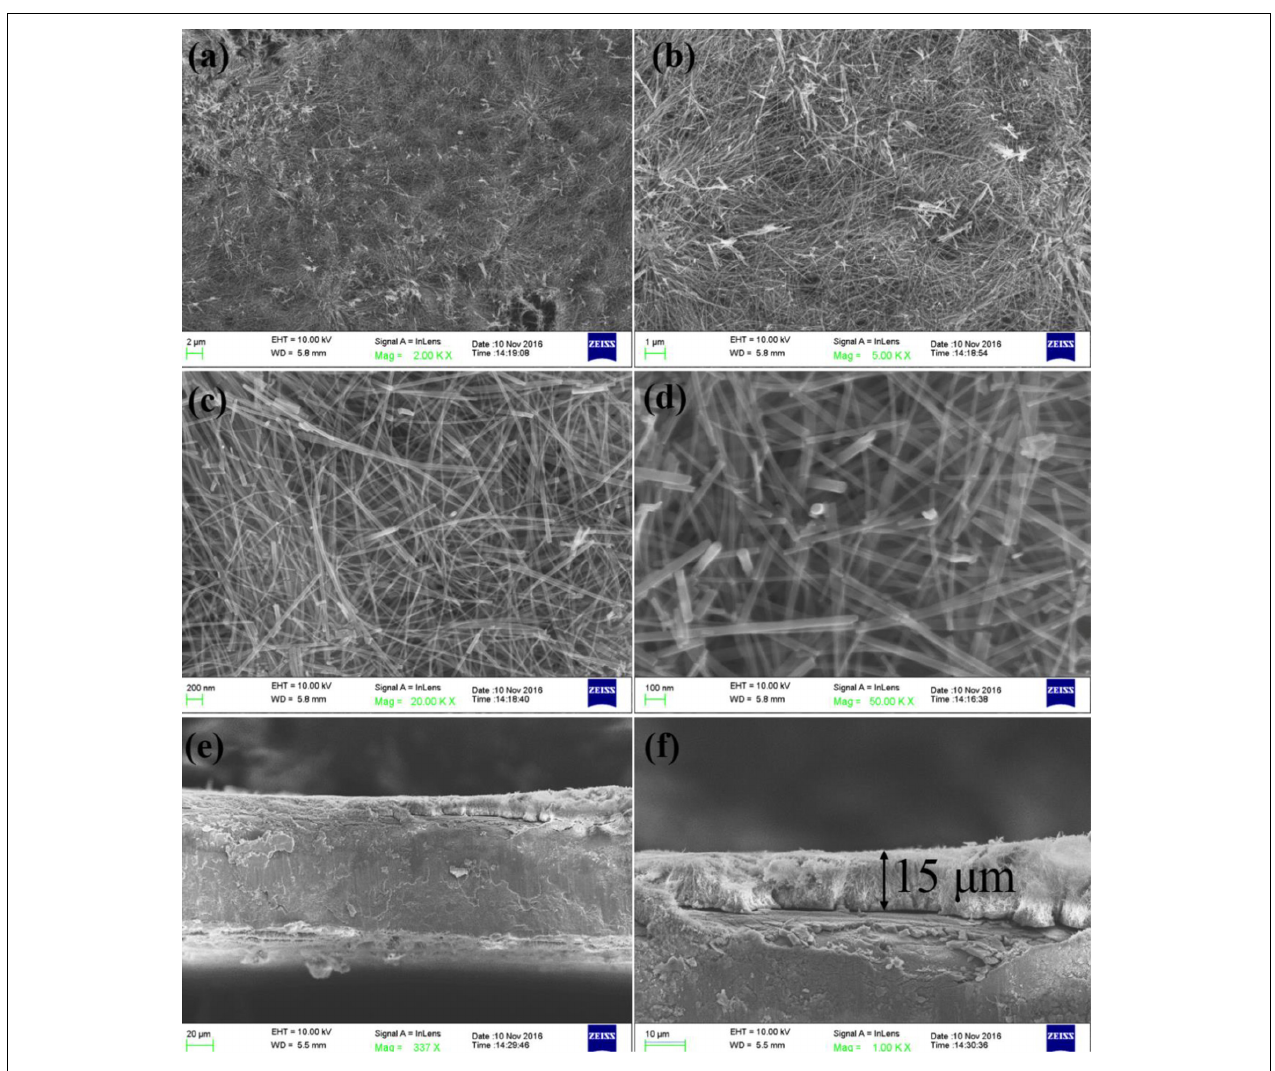
FIGURE 3 | (a–f) Are all SEM images of TiO 2 /Ti. Oriented TiO 2 NWAs are assembled on the Ti